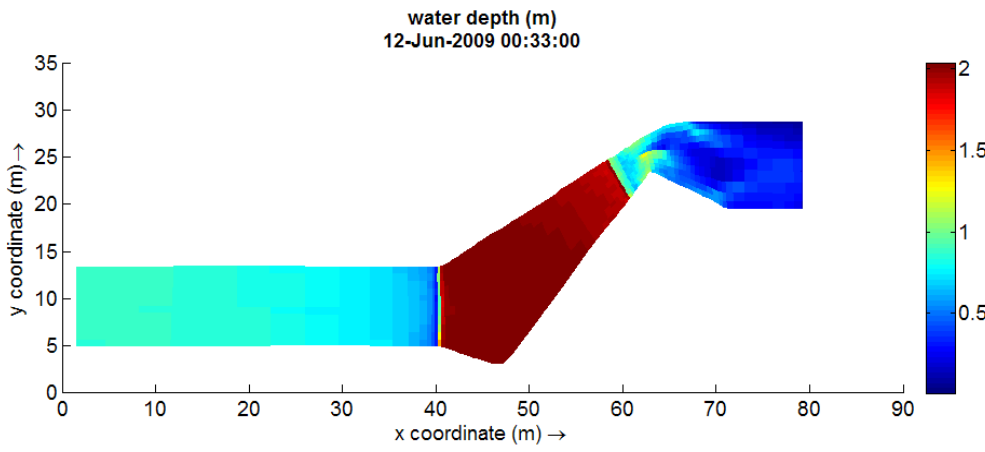
Figure 20. Depth variation in the flow system for HDCV scenario (see Table